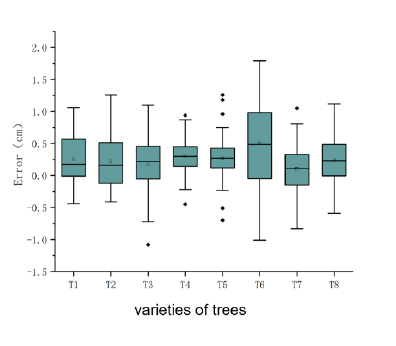
(b) Comparing new device with diameter tape. Figure 9. Distribution of DBH error among different tree species. Figure 9. Distribution of DBH error among different tree species. Table 3. Comparison of DBH data of different diameter orders. Table 3. Comparison of DBH data of different diameter orders.